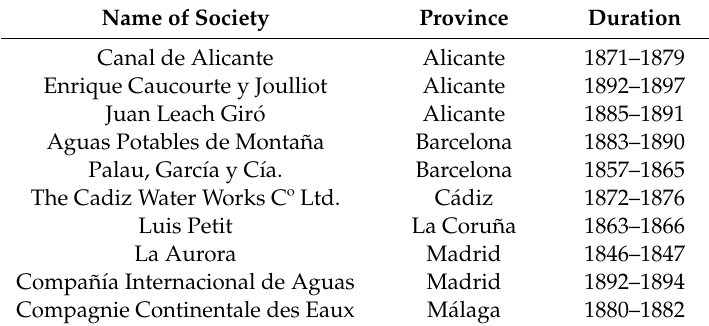
Table 2. Examples of companies established in the 19th century that were liquidated in less than 10 years.